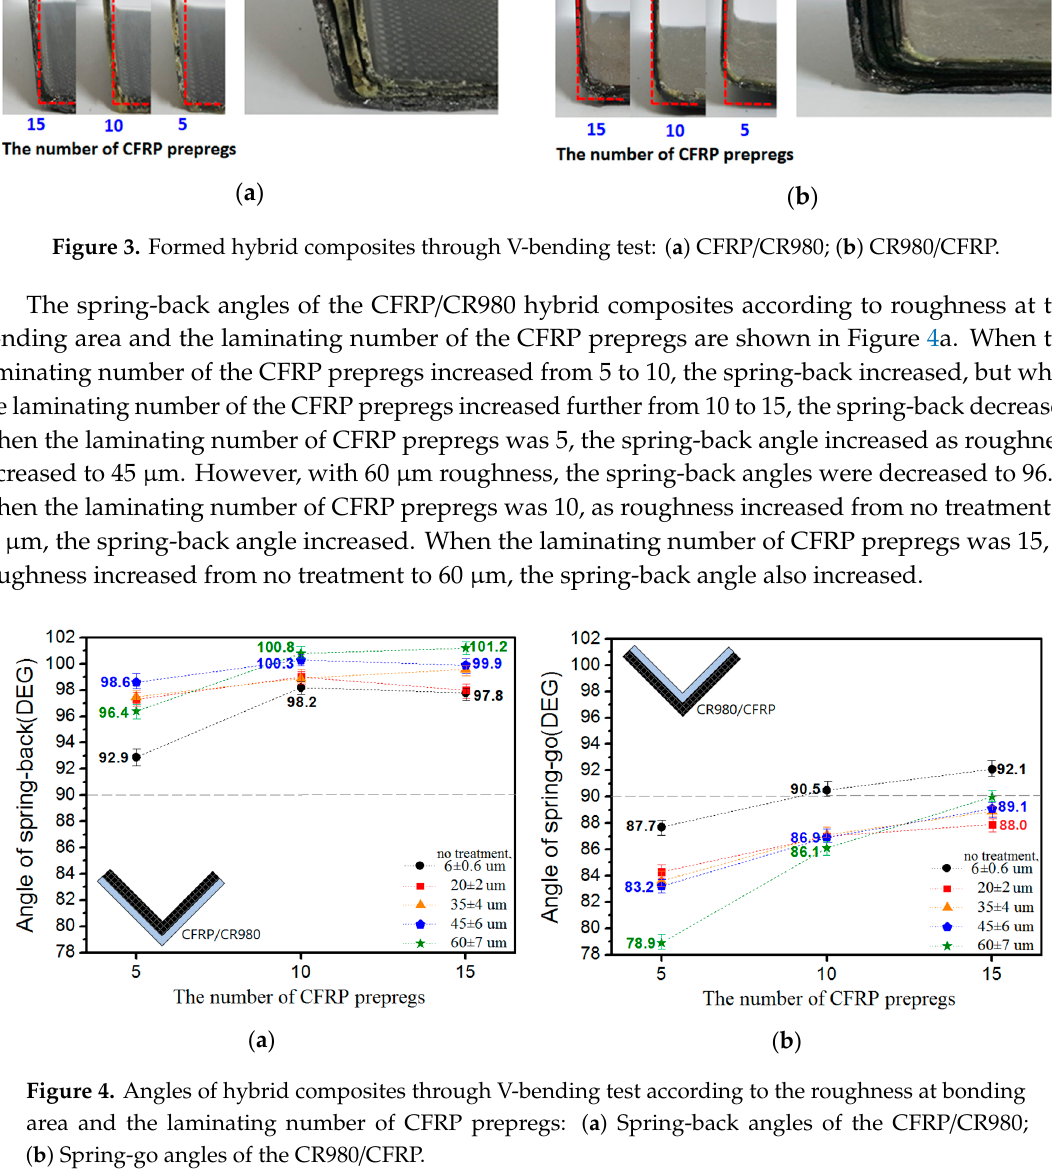
Figure 4. Angles of hybrid composites through V-bending test according to the roughness at bonding area and the laminating number of CFRP prepregs: ( a ) Spring-back angles of the CFRP/CR980; ( b ) Spring-go angles of the CR980/CFRP.